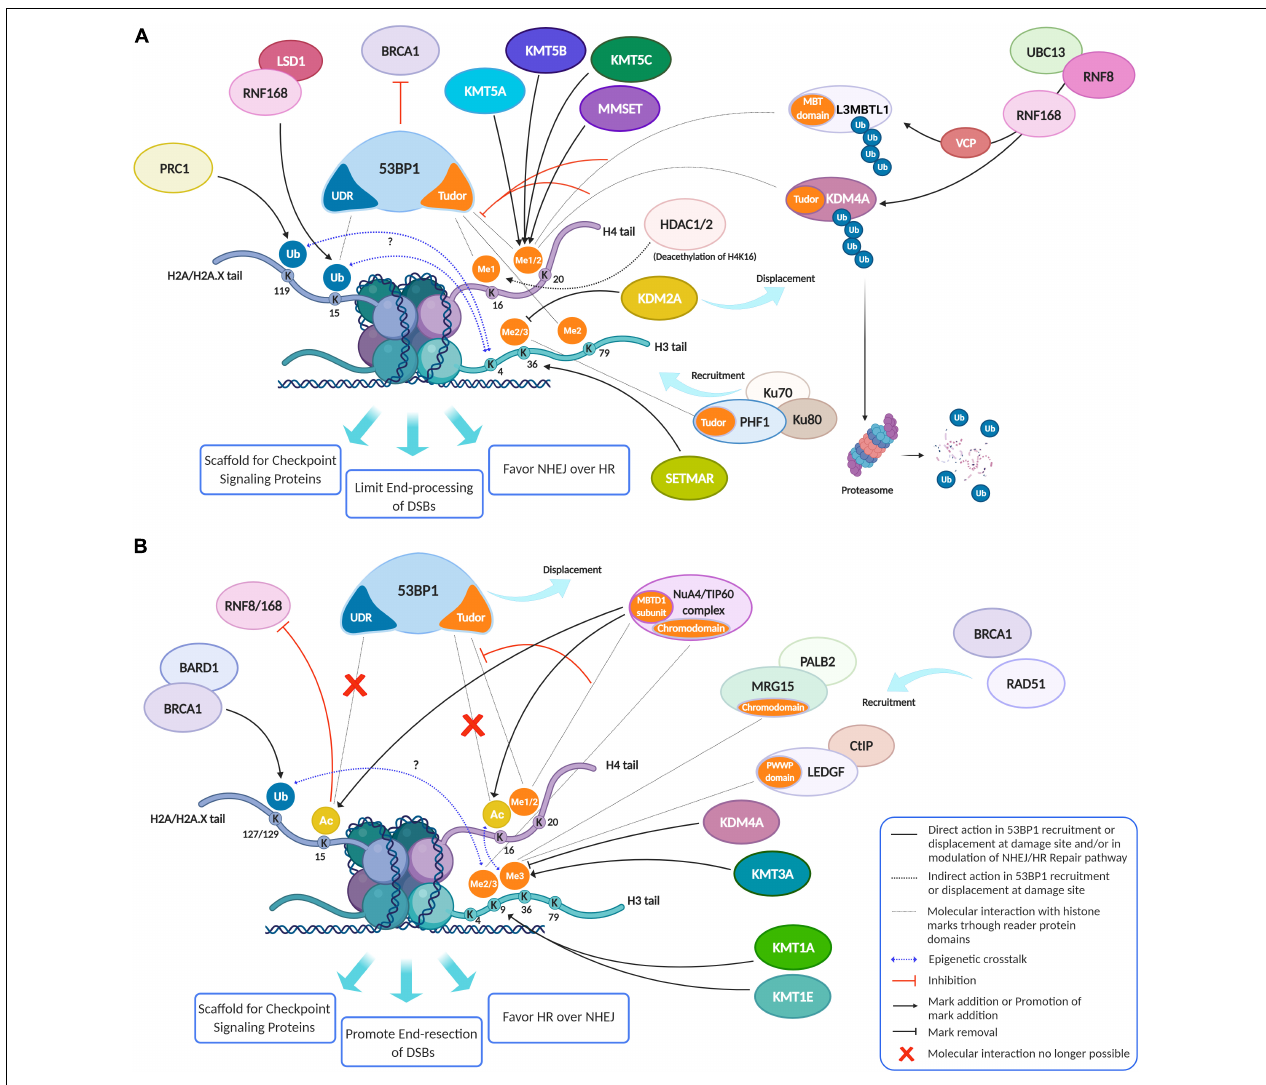
FIGURE 3 | Histone modifications, dynamically added or removed around the DNA damage site, constitute an integrated signal for the DSBs repair pathway choice. (A) 53BP1 is a master regulator of DNA double-strand break repair pathway choice toward NHEJ and its binding to chromatin is mainly regulated by specific histone modifications, comprising H2A ubiquitylation and H3 and H4 methylation. Indeed, specific HPTMs can generate a docking site for 53BP1, which binds the ubiquitinated H2A/H2A.X K13/15/119 through its UDR motif and H4K20me2, H4K16me1, and H3K79me2 through its tandem Tudor domain. Therefore, despite H4K20me2 being the main histone mark involved in 53BP1 recruitment, other marks may contribute to it. For example, the deacetylation of H4K16 by HDAC1/2 indirectly promotes the 53BP1 recruitment and the NHEJ over HR, because it makes possible the methylation of this lysine residue. Under normal conditions, the H4K20me2 mark is masked by various interacting proteins, including L3MBTL1 and KDM4A/JMJD2A. Upon DNA DSBs induction, the ATM phosphorylation cascade promotes the recruitment of the E3 ubiquitin ligase RNF8 to the DNA damage site, which, together with the E2 ubiquitin ligase UBC13, promotes the relocation of the E3 ubiquitin ligase RNF168 to the DNA break sites. LSD1 may favor the 53BP1 recruitment interacting with RNF168 and/or thanks to a possible epigenetic cross-talk between H3K4 demethylation and H2A ubiquitylation. RNF168 catalyzes in turn the H2A K13/15 mono-ubiquitination and the poly-ubiquitination of L3MBTL1 and KDM4A, leading to RNF8-dependent degradation of KDM4A and to VCP-mediated and ubiquitin-dependent removal of L3MBTL1 from chromatin, favoring the unmasking of H4K20me2 and the loading of 53BP1 around the damaged site. LSD1 can also disadvantage 53BP1 recruitment, negatively regulating the interaction between p53 and 53BP1 (not shown). After DSB induction by IR, the H3K36me2 markedly increases, improving the association of early NHEJ factors such as Ku70/Ku80 and NBS1 at the damage site. Once activated, ATM (not shown) may negatively regulate KDM2A chromatin-binding capacity, favoring its displacement, which favors an increase of H3K36 di-methylation mark near the DNA damage sites by SETMAR. H3K36me3 can favor the retention of the NHEJ-associated factor PHF1, which is recruited in a Ku70/Ku80 dependent way and which supports an open chromatin for the efficient DNA repair. In contrast to H3K36me2, H3K36me3 regulates both NHEJ and HR, probably depending on the relative abundance of its reader factors and/or by the chromatin context. In this regard, pre-existing transcription-associated and cell cycle-regulated histone modifications together with those damage-induced regulate the DNA repair pathways. (B) The pre-existing H3K36me3 mark at actively transcribed gene bodies favors DNA repair by HR pathway choice: in human cells, both LEDGF (Lens epithelium-derived growth factor), via its PWWP reader domain, and MRG15, via its chromodomain, can bind H3K36me3, promoting the recruitment of CtIP and PALB2, two crucial factors for the DNA end-resection and strand invasion, respectively. Moreover, mutually exclusive histone modifications can contribute to tip the balance between HR and NHEJ in DSB repair pathway choice: a switch between ubiquitylation and acetylation on H2AK15 and H4K16